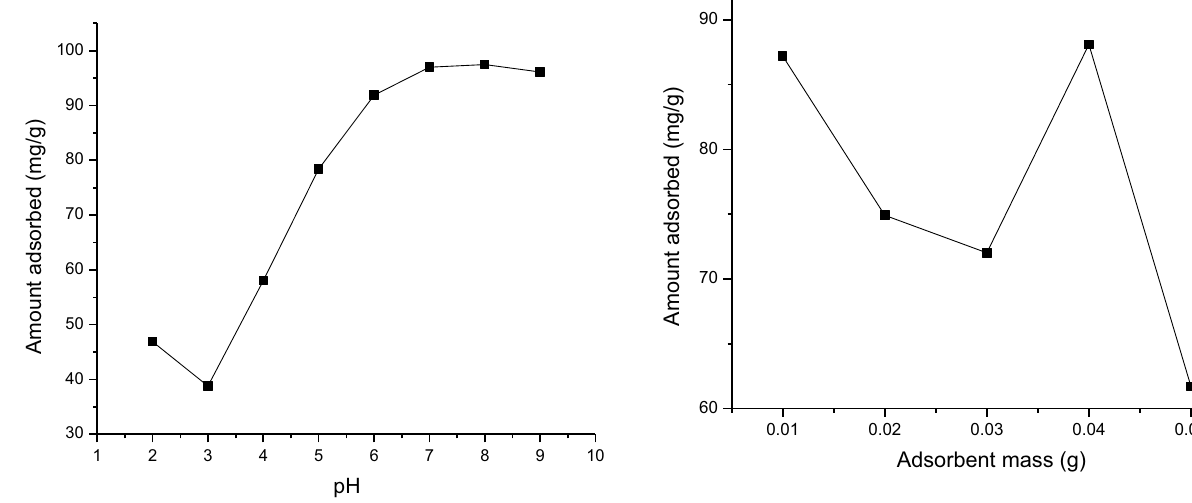
Fig. 5 Effect of pH on adsorption of Pb 2+ ions on WM-Fe